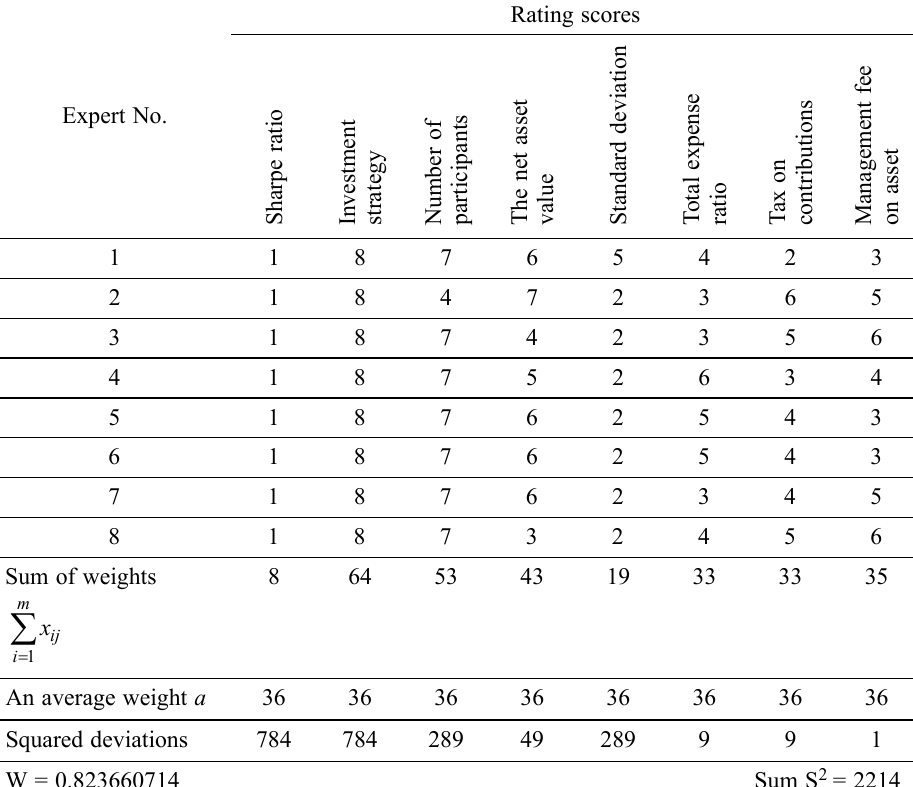
Table 2. Data of expert evaluation and result calculation of the compatibility analysis